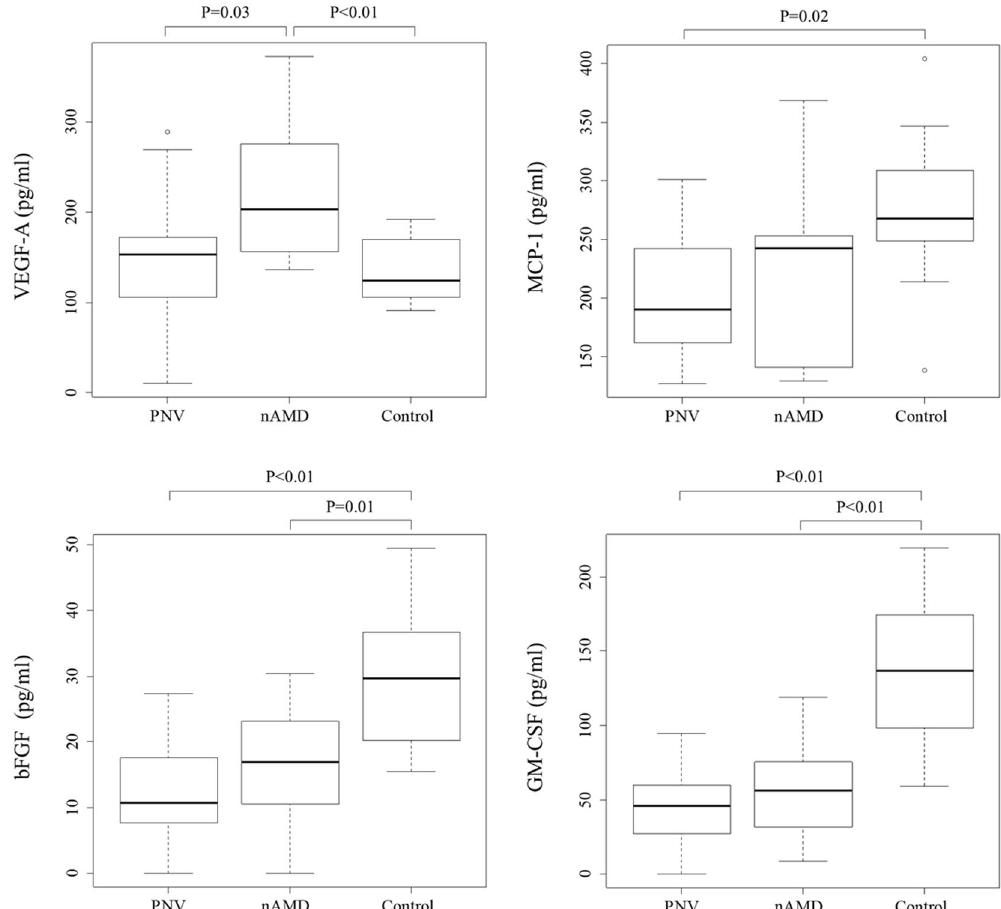
Figure 1. Baseline median concentrations of vascular endothelial growth factor (VEGF)-A, monocyte chemoattractant protein (MCP)-1, basic fibroblast growth factor (bFGF) and granulocyte macrophage colony- stimulating factor (GM-CSF) among the three groups. The concentrations of VEGF-A were significantly higher in the neovascular age-related macular degeneration (nAMD) group compared to the pachychoroid neovasculopathy (PNV) and control groups ( p = 0.02 and p = 0.01, respectively). The boxes represent the median and interquartile ranges, with the line in the middle of the boxes corresponding to the median